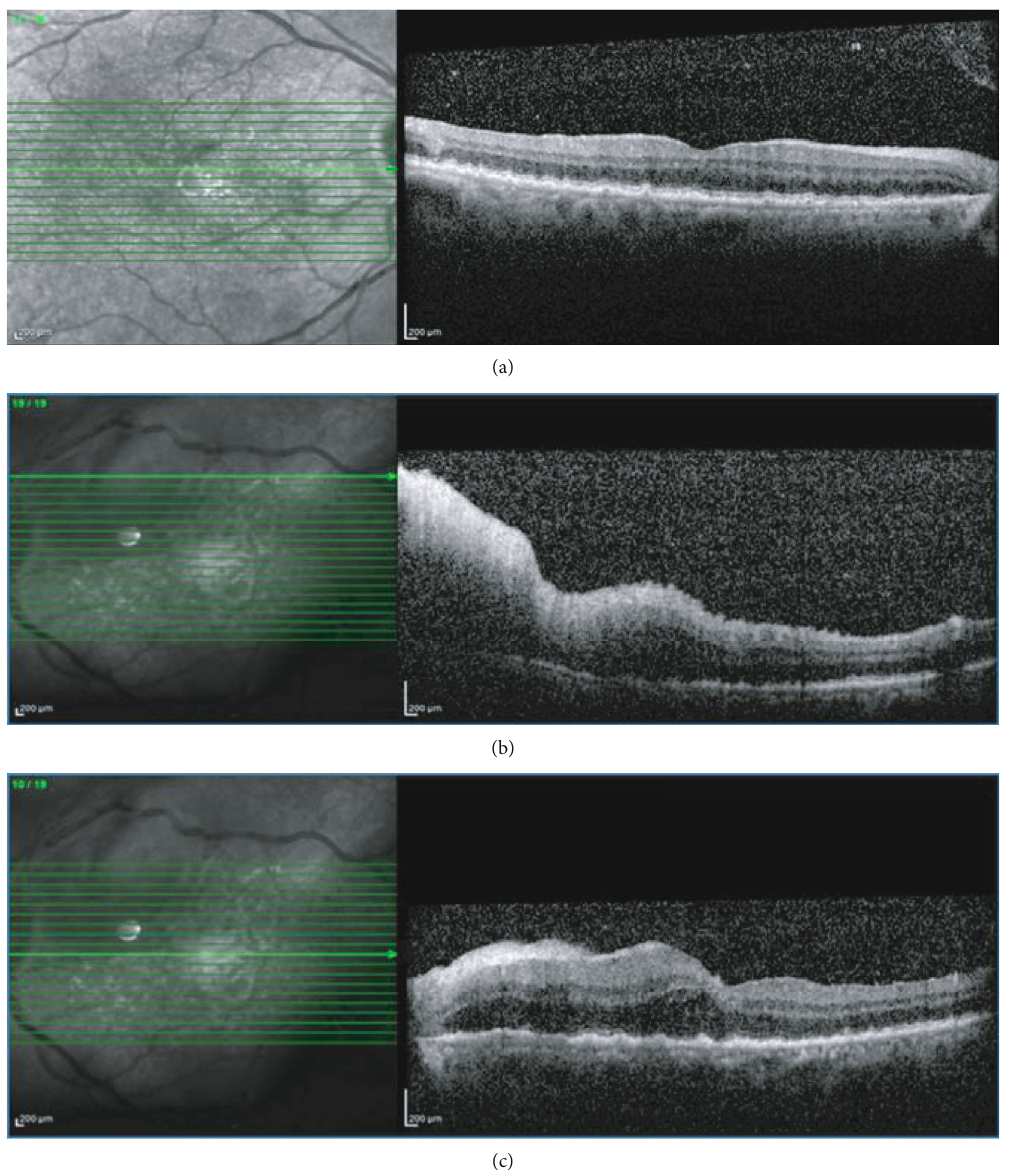
Figure 1: Spectral domain OCT (SD-OCT) at the fi rst presentation. (a) Right eye: multiple tiny Drusen-like RPE elevations. (b, c) Left eye: retinal edema, increased central macular thickness (CMT), multiple RPE irregularity simulating Drusen, and inner retinal hyperre fl ective lesion indicating retinitis at the superotemporal of the optic